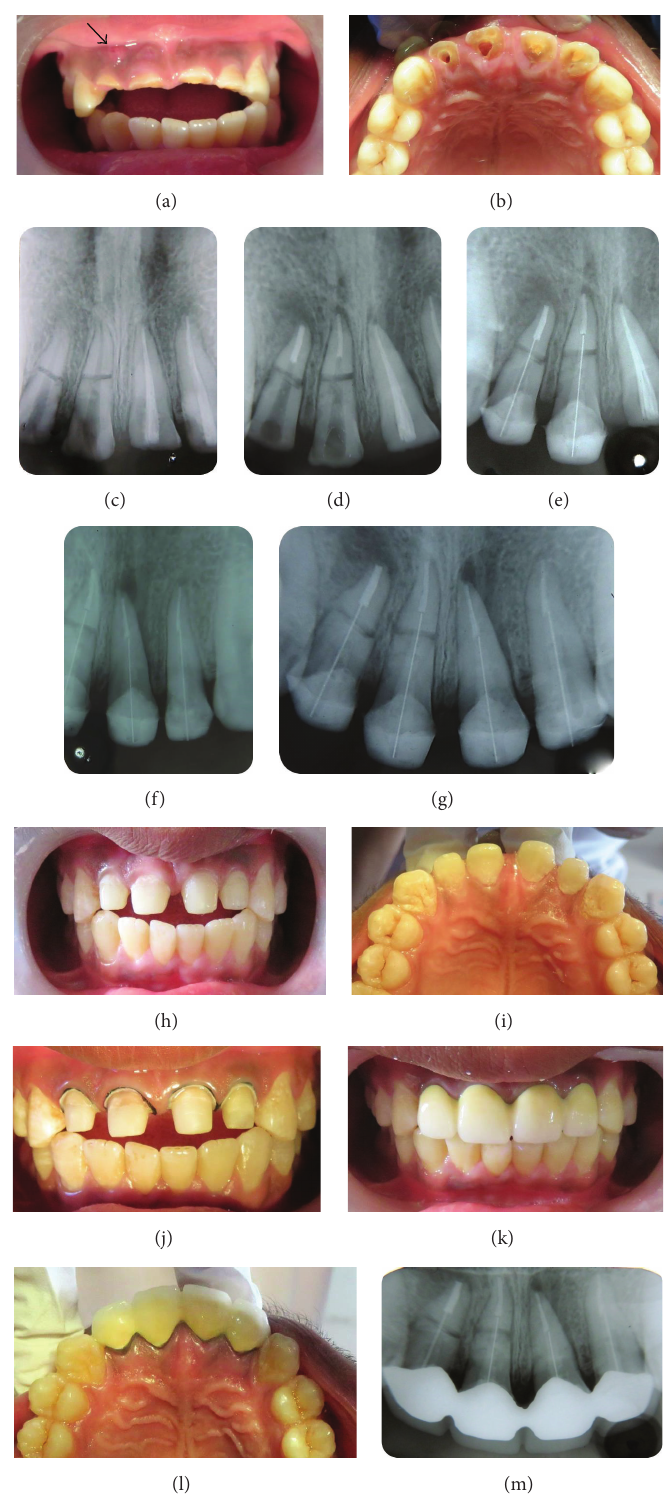
Figure 1: Procedural steps. (a) Preoperative clinical photograph (labial view) demonstrating complicated crown fractures of upper central and lateral incisors and the presence of a sinus tract on labial gingiva. (b) Preoperative palatal view. (c) Preoperative radiograph showing horizontal root fracture at the middle third of upper right central and lateral incisors. (d) Sectional obturation using gutta percha cone and AH plus sealer followed by post space preparation. (e) Core build-up following cementation of post. (f) Post and core treatment of maxillary left central and lateral incisors. (g) Radiograph illustrating post and core treatment of the four upper incisors. (h) Clinical photograph after post and core treatment of upper incisors (labial view). (i) Palatal view. (j) Tooth preparation to receive coronal coverage. (k) Cementation of porcelain fused to metal crowns (labial view). (l) Palatal view. (m) Postoperative radiograph after cementation of the